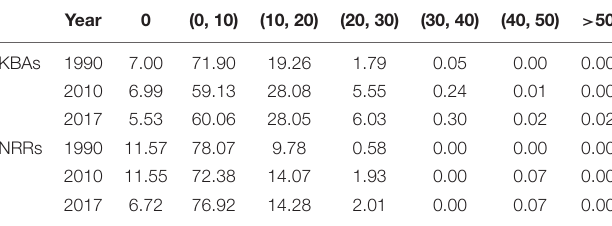
TABLE 3 | Proportions of areas with various degree of human pressures in key biodiversity areas (KBAs) and national natural reserves (NNRs) during 1990–2017